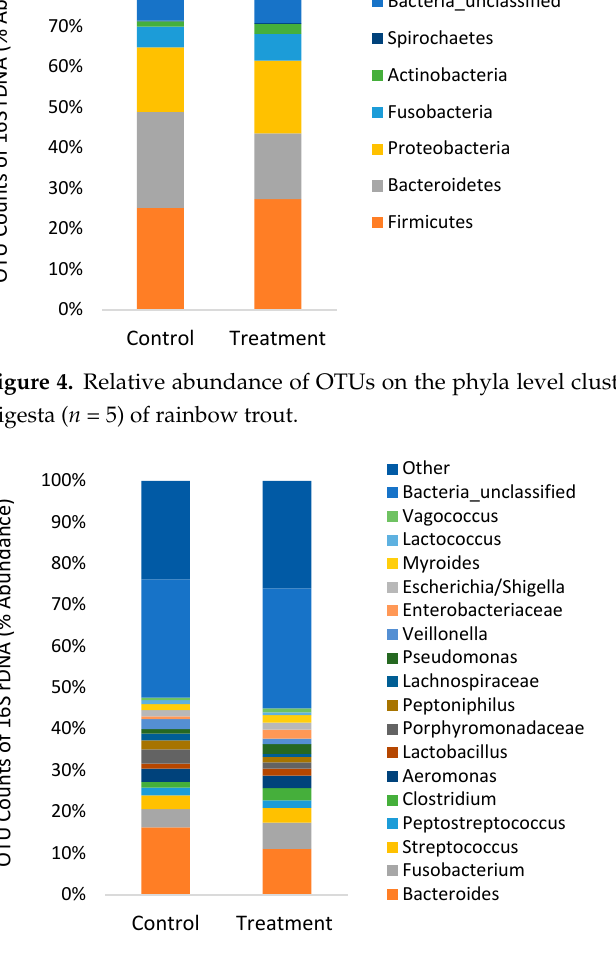
Figure 5. Relative abundance of OTUs on the genus level clustered from 16S rDNA from the gut digesta ( n = 5) of rainbow trout.